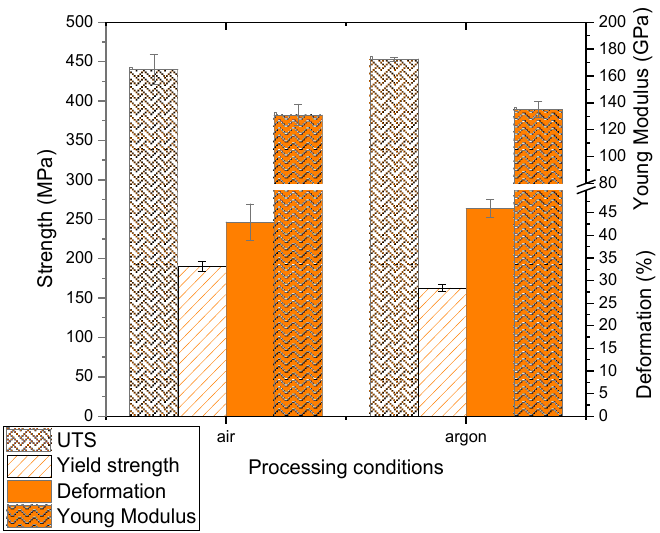
Figure 12. Mechanical properties of PMD specimens after TT2 vs. the processing conditions of air and argon.